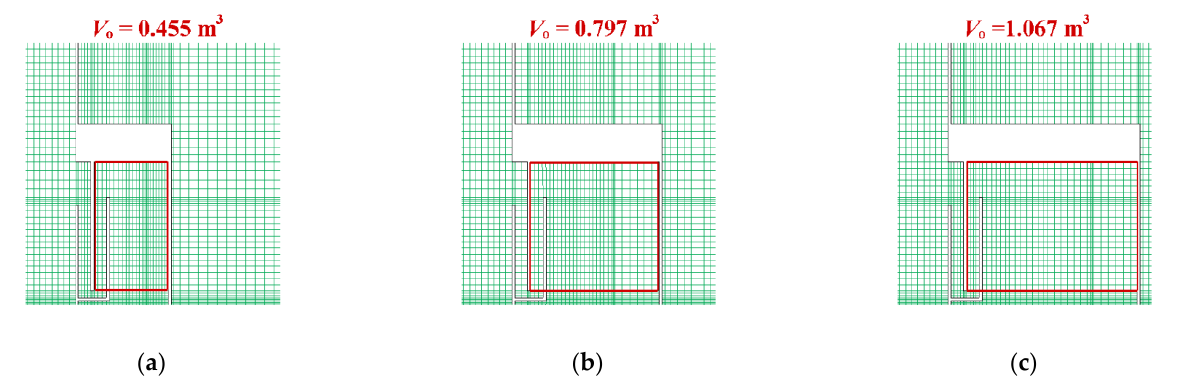
Figure 4. Comparison of computational models. ( a ) Chamber_1, ( b ) Chamber_2, and ( c ) Chamber_3. The red rectangular wireframe denotes the volume of the air chamber.